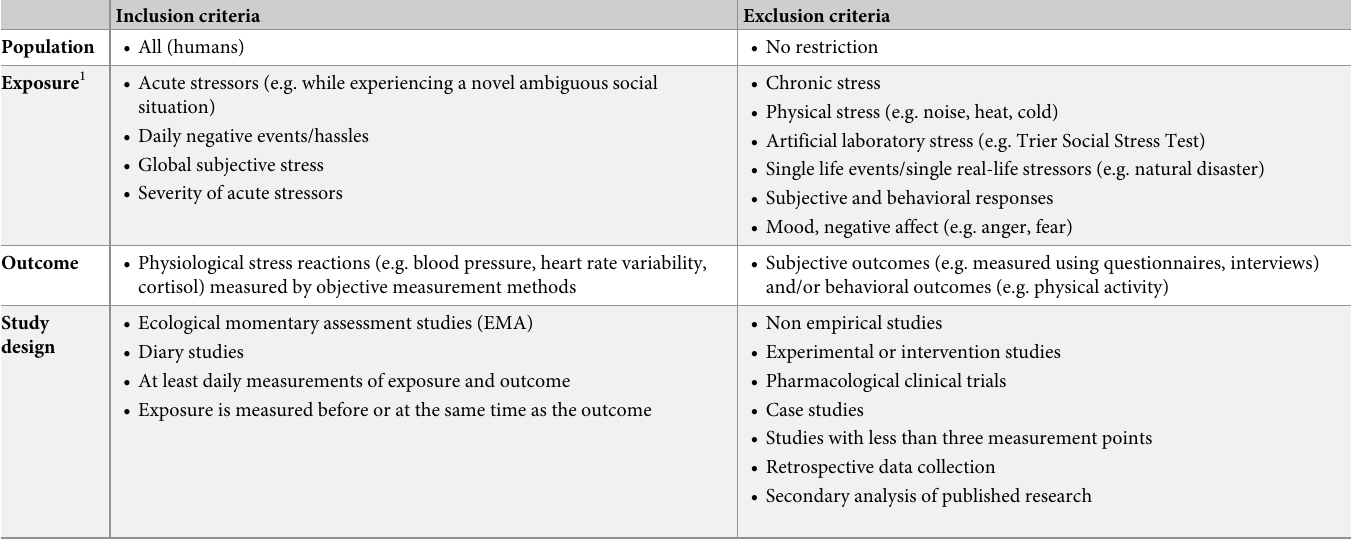
Table 1. Inclusion and exclusion criteria during study selection.